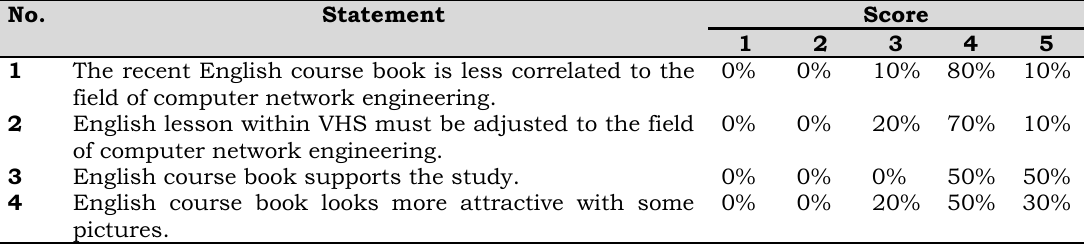
Table 2. Students’ perception and expectation of the English